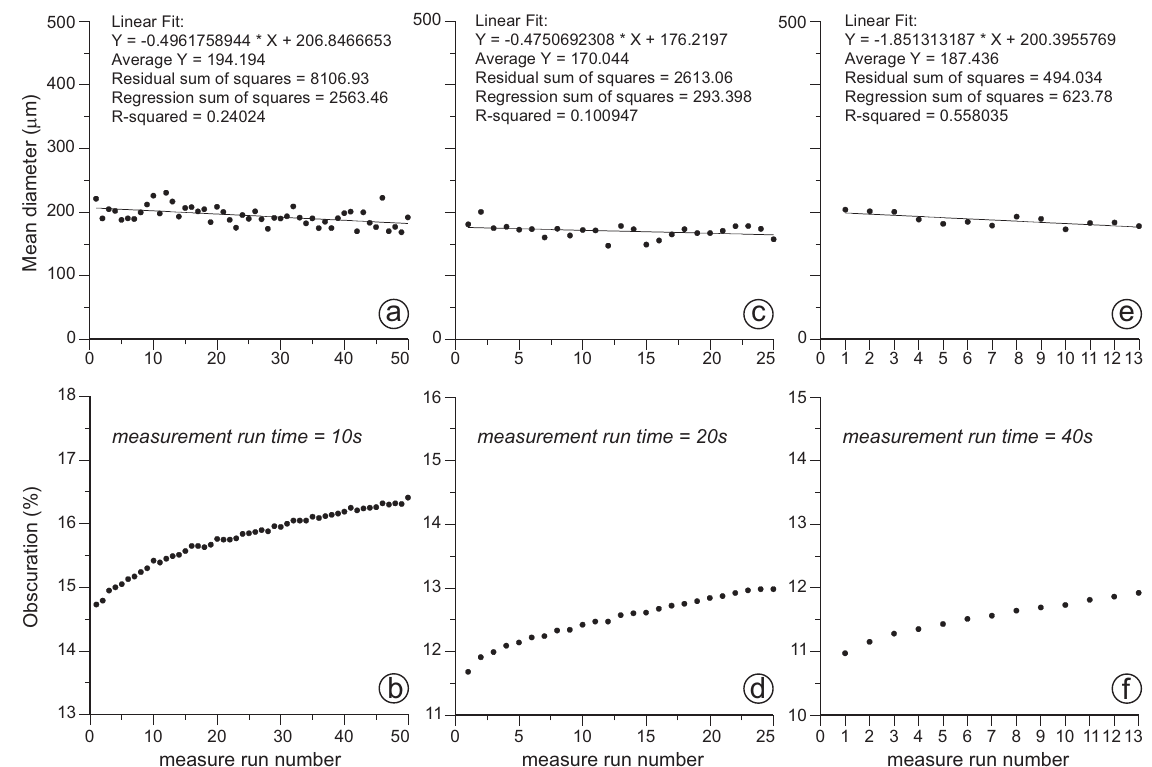
Fig. 12. Results of measurement precision tests performed at different run times on sample CABRE3 by the Hydro 2000 MU dispersion unit. (a) Test MP2000 10 on sub-sample aliquot CABRE3h; mean diameter value evolution with increasing the number of measurement runs. Data statistics are provided. (b) Laser obscuration value progression during the same test. (c) Test MP2000 20 on sub-sample aliquot CABRE3i; mean diameter value evolution with increasing the number of measurement runs. Data statistics are provided. (d) Laser obscuration value progression during the same test. (e) Test MP2000 40 on sub-sample aliquot CABRE3j; mean diameter value evolution with increasing the number of measurement runs. Data statistics are provided. (f) Laser obscuration value progression during the same